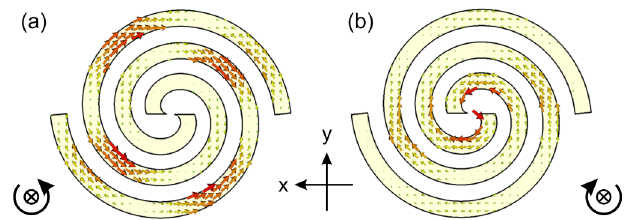
FIG. 7. Current distributions inside the nanospiral for incident (a) LCP and (b) RCP light at wavelength 1 : 84 (cid:1) m . The two polarizations excite different modes. The current distributions correspond to the regions with enhanced optical chirality as identified in Fig. 6.